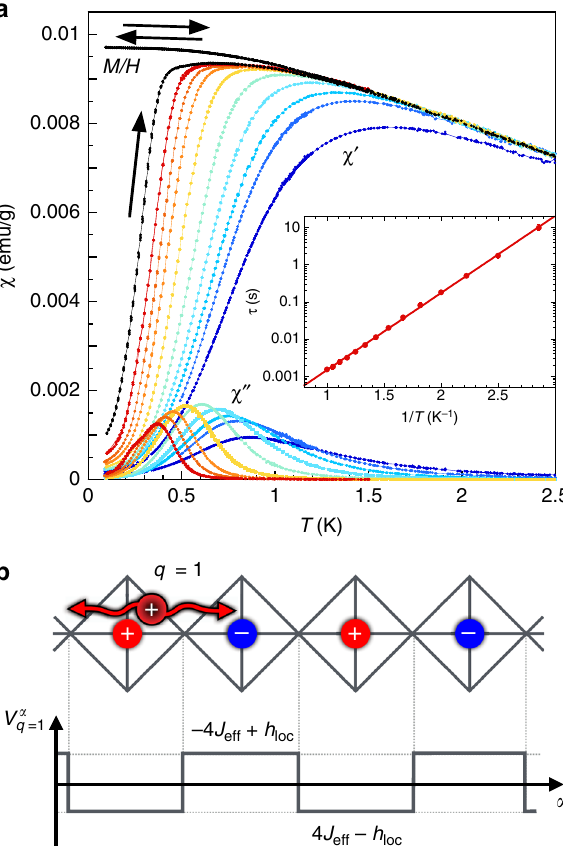
Fig. 3 Dynamical properties and diffusion of the excitations. a Low temperature dependence of the ZFC-FC magnetization performed in 5 mT below 4 K ( black symbols ). The two curves depart below about 1.5 K. On the same graph are shown the real part χ ′ and imaginary part χ ″ of the AC susceptibility vs T at several frequencies f from 0.011 Hz ( red ) to 570Hz ( blue ) with the intermediate frequencies 0.057, 0.21, 1.11, 5.7, 21, 57 and 111 Hz. Inset : τ vs 1/ T , where τ = 1/2 π f peak and f peak is the maximum of χ ″ ( f ) measured at constant temperature T . The line is a fi t to an Arrhenius law τ = τ τ = (1.2 ± 0.2) × 10 − 5 s and E = 4.8 ± 0.1 K. 0 exp( E / T ) where 0 b Two-dimensional representation of a string of tetrahedra on which an elementary excitation carrying a charge q = +1 ( red disc with black border ) diffuses in the fragmented regime Spatial periodic potential V α felt by the q diffusing charge and induced by the underlying static charge crystal, where α refers to the tetrahedron type: α = in carries an ordered charge q in ¼ þ 1 o ¼ (cid:2) 1 ( blue ( red ) and α = out carries q out o